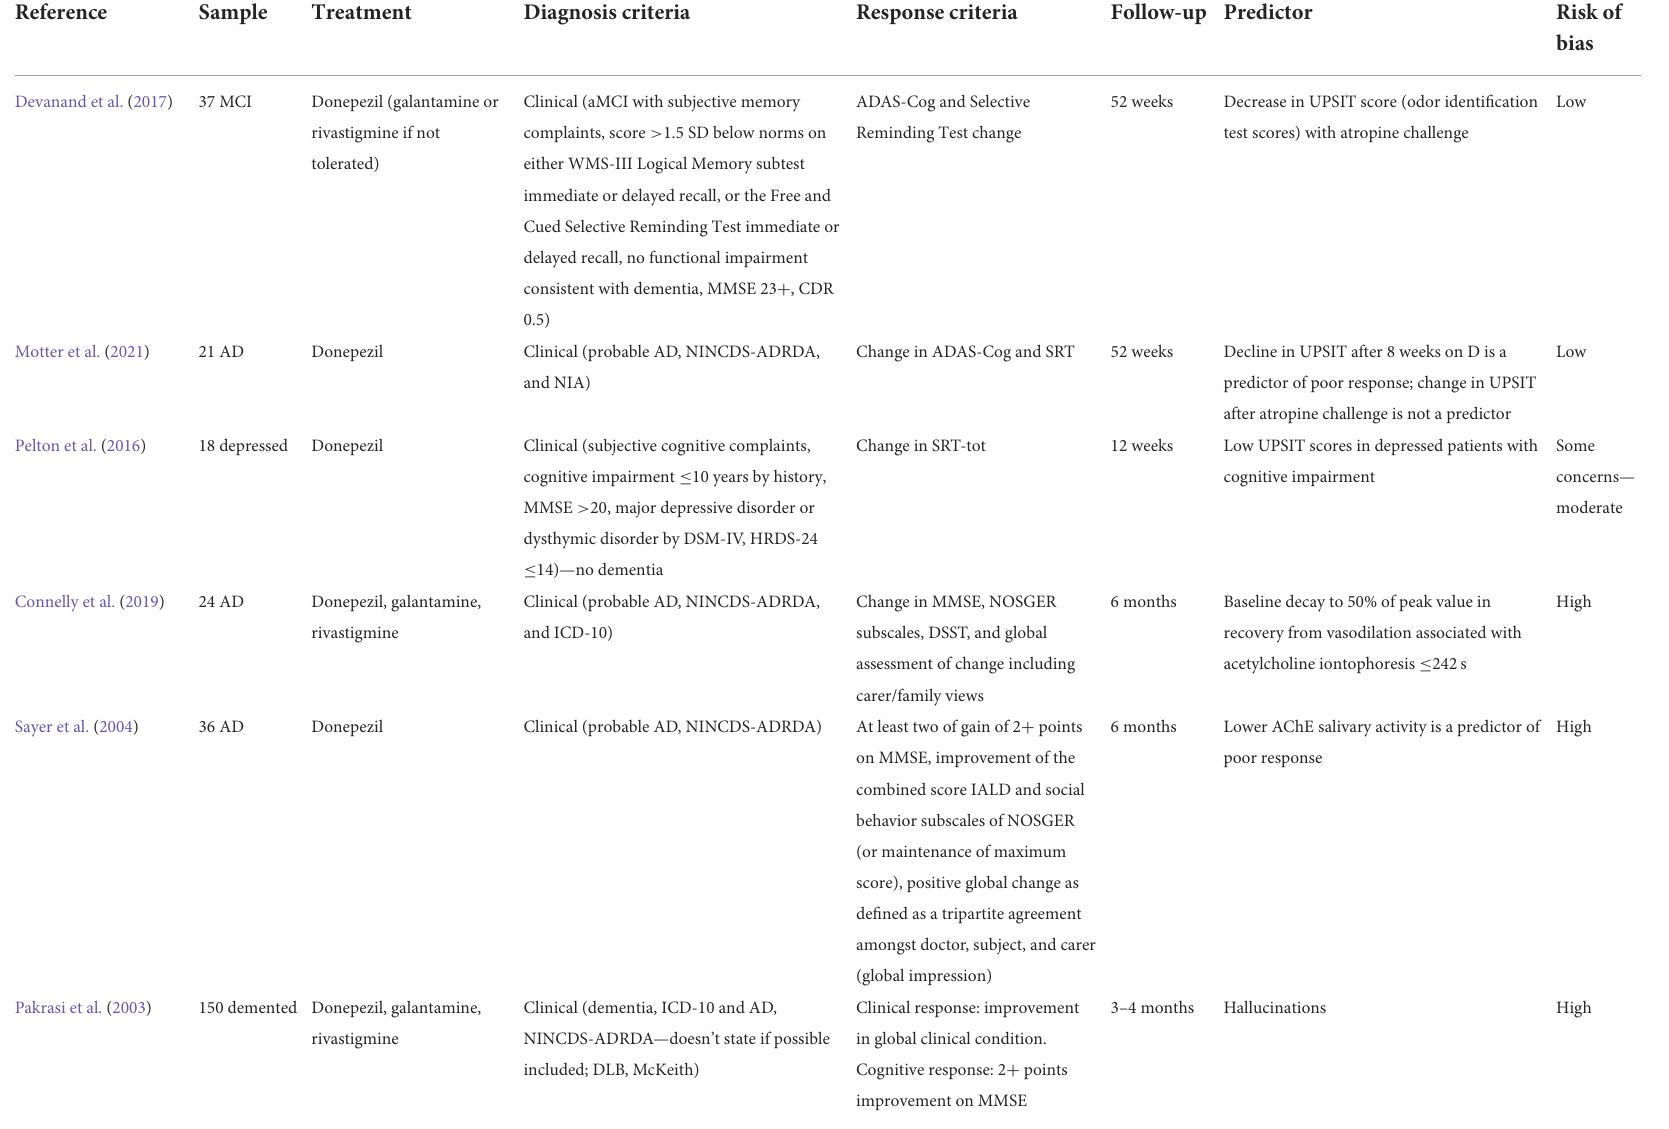
TABLE 2 Indicators of cholinergic